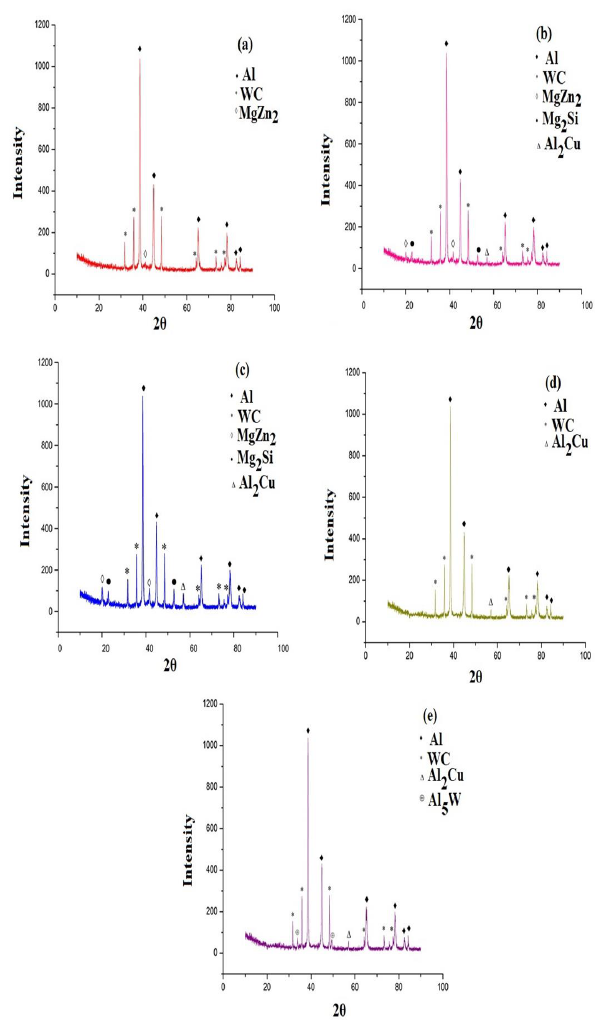
Figure 4. X-Ray diffraction analysis of Al7075-WC composite of ( a ) non-aged, ( b ) aged at 150 °C, ( c ) 250 °C, ( d ) 350 °C; ( e ) 450